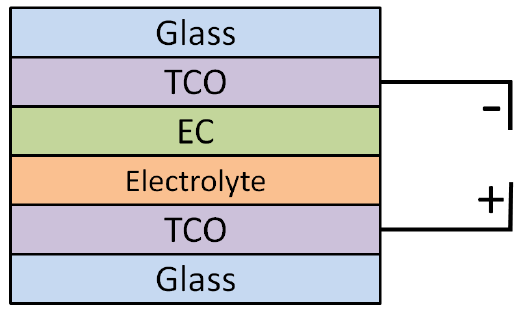
Figure 1. Device structure of a conventional ECD.